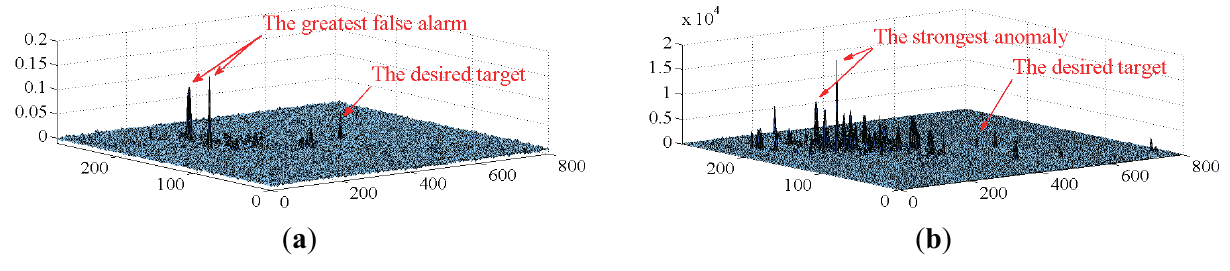
Figure 1. 3D cube of the Target Detection Self-Test dataset including HyMap reflectance images of Cook City in Montana, USA, cover an area of 280 × 800 pixels with 126 spectral bands.